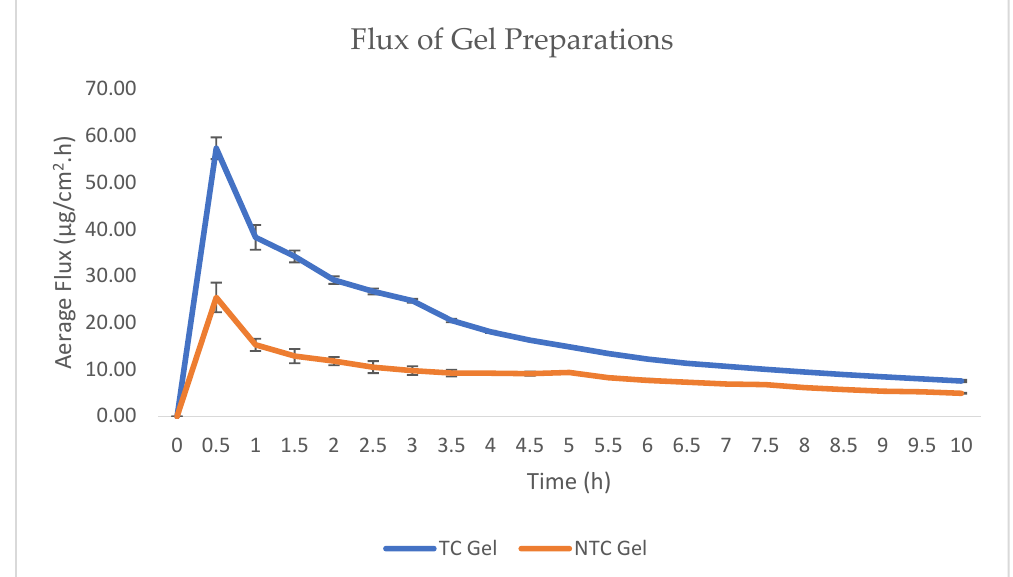
Figure 10. Flux comparison of transethosomal catechin gel and non-transethosomal catechin gel.